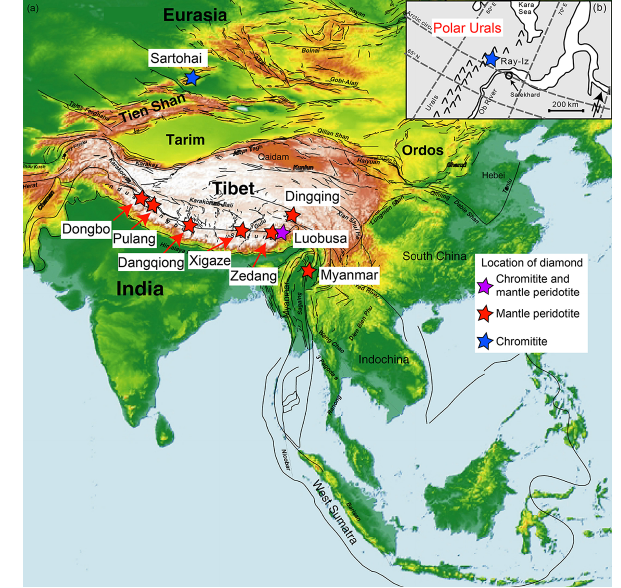
Figure 17. Locations of ophiolite-type diamonds discovered so far. Six locations, including Dongbo, Purang, Dangqiong, Xigaze, Zedang, and Luobusa, and are situated along the Yarlung Zangbo suture zone. One location is at Dingqing in the Bangong–Nujjiang suture, Tibet, one in Myanmar, one in Sartohai in Xinjiang Province (China), and one (see inset map) in the polar Urals, Russia.